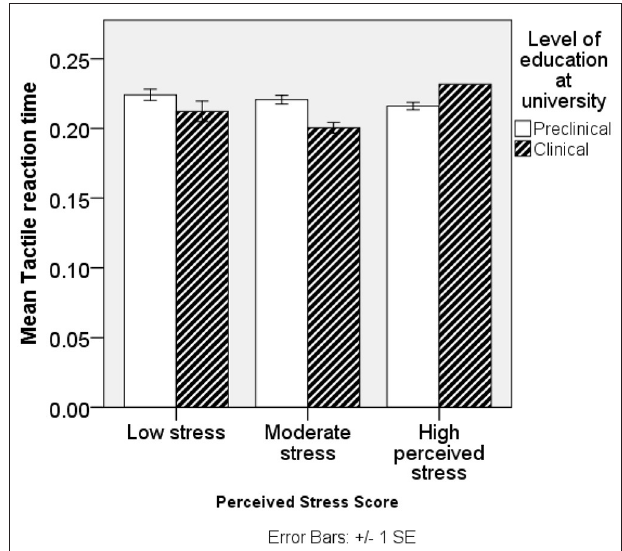
FIGURE 1 | Relationship between perceived stress scores and reaction time among study participants.